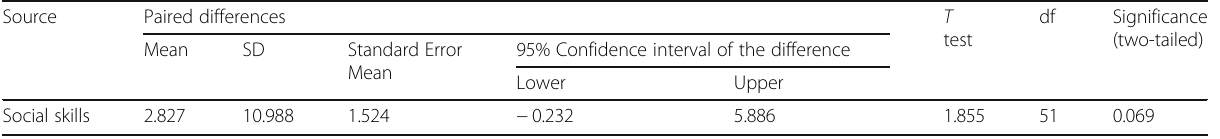
Table 8 Analysis of post-test, follow up phase using dependent t test analysis Source T